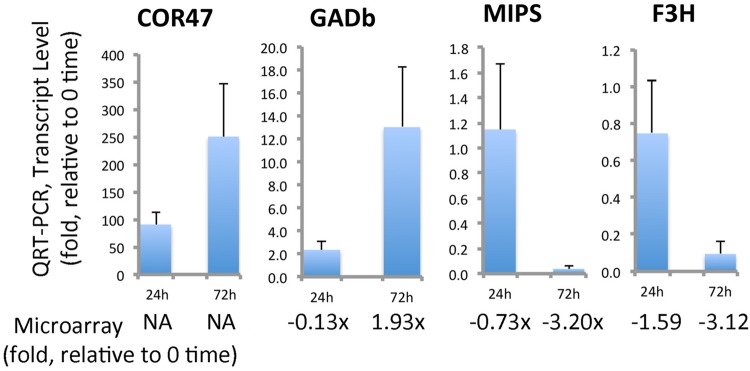
Quantitation of selected cold-responsive transcripts. COR47 (positive control gene for cold stress), GADb (glutamate decarboxylase, ortholog b), MIPS (myo-inositol-1-phosphate synthase), and F3H (flavonone-3-hydroxylase). Data represent average values of technical replicates, error bars indicate standard deviations. Primers utilized for this qRT-PCR analysis can be found in Supplementary File S4. The qRT-PCR is compared to fold-changes obtained from the microarray analysis (Supplementary File S3).